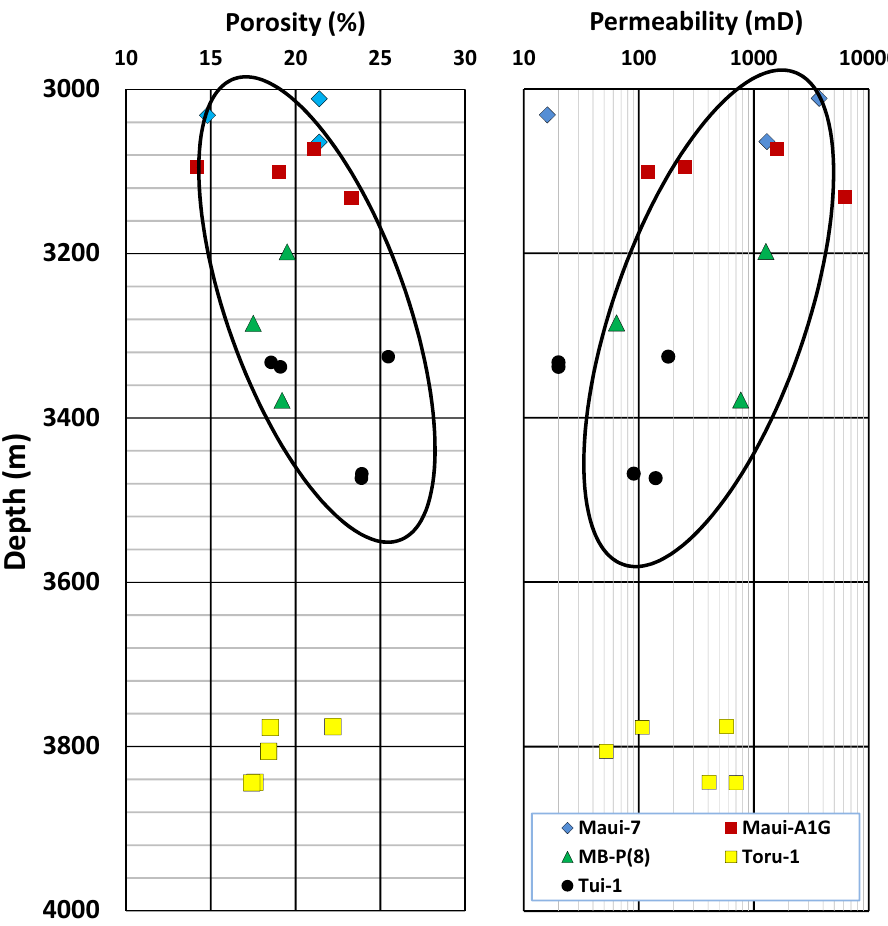
Fig. 5 Porosity and permeabil- ity graphs versus depths for the selected Kaimiro Formation in the studied